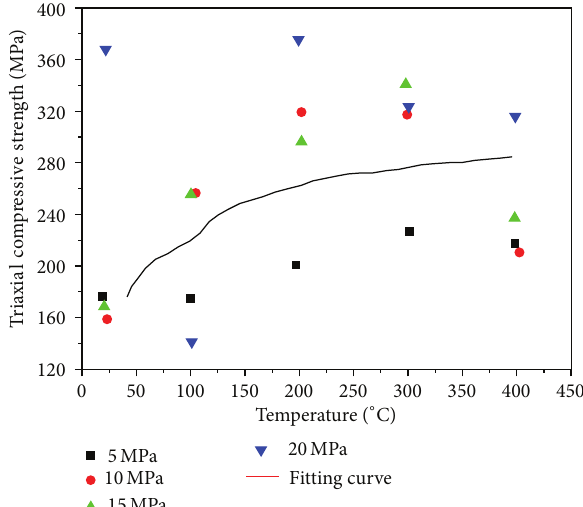
Figure 11: Relationship between triaxial compressive strength and temperature with constant confining pressure.